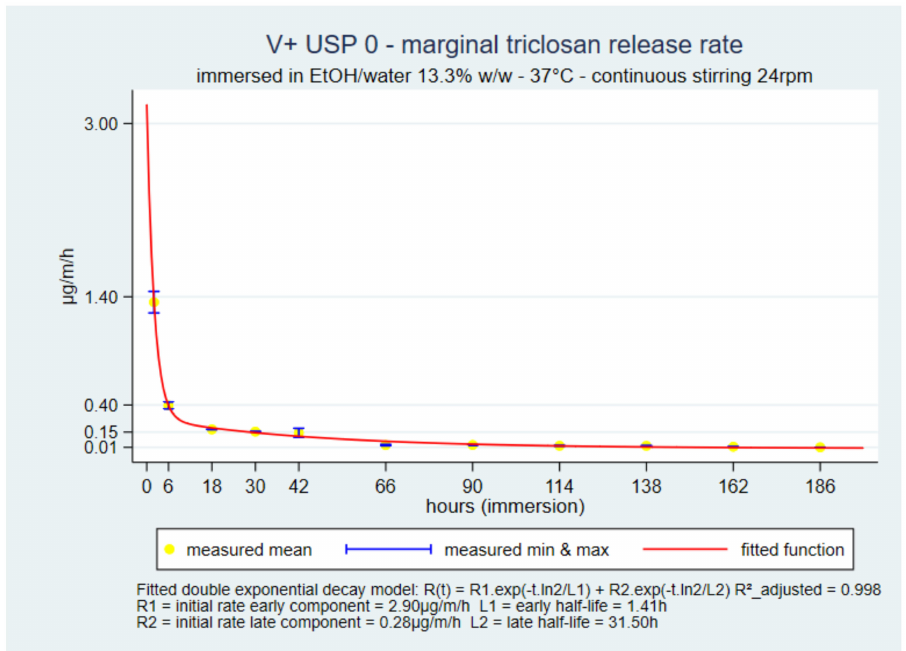
Figure 5. V+ 0 in 13.3% w / w marginal release rates up to 7